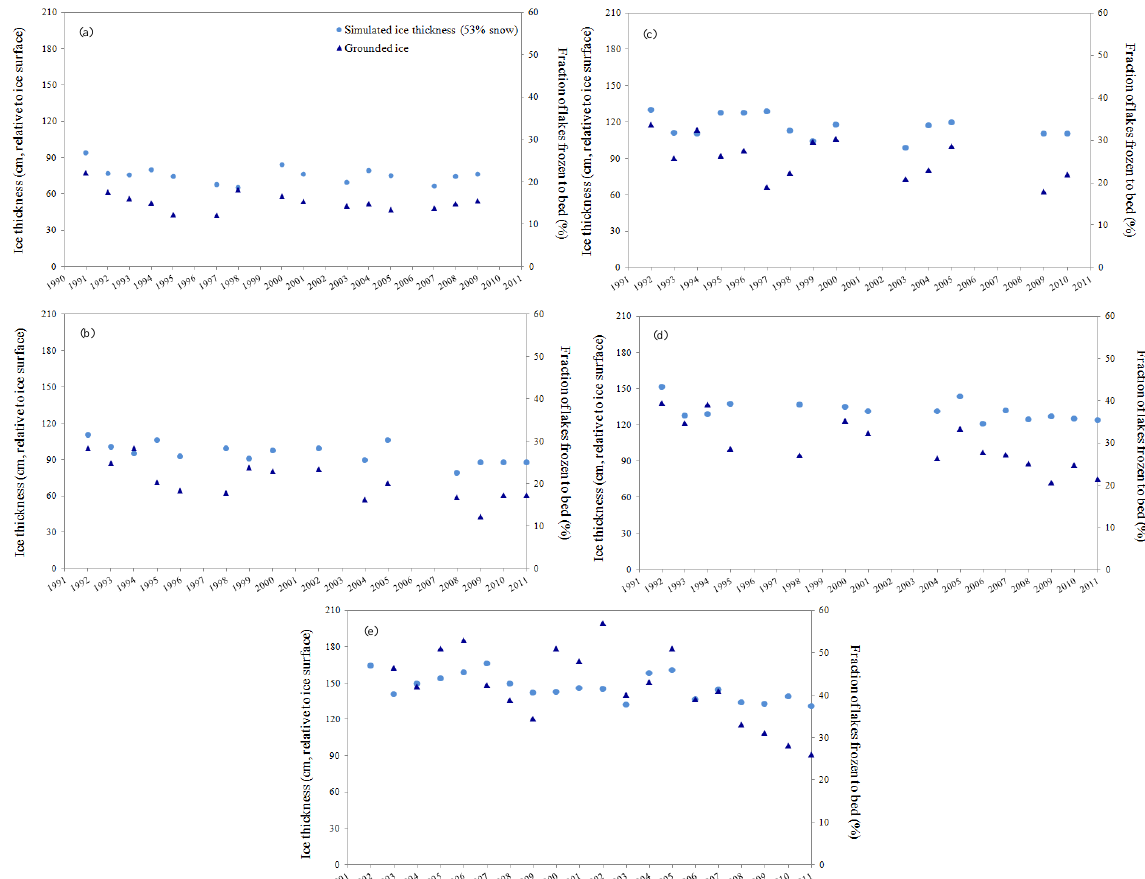
Figure 4. Monthly fractions of lakes frozen to the bed as derived from analysis of available ERS images and simulated ice thickness on day of ERS acquisition (1991 to 2011) – (a) December; (b) January; (c) February; (d) March; (e) April.